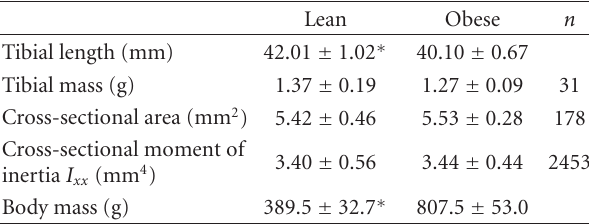
Figure 1: Exemplar L 6 ( v ) and tibial ( t ) transverse cross-sectional micro-CT images for lean and genetically obese